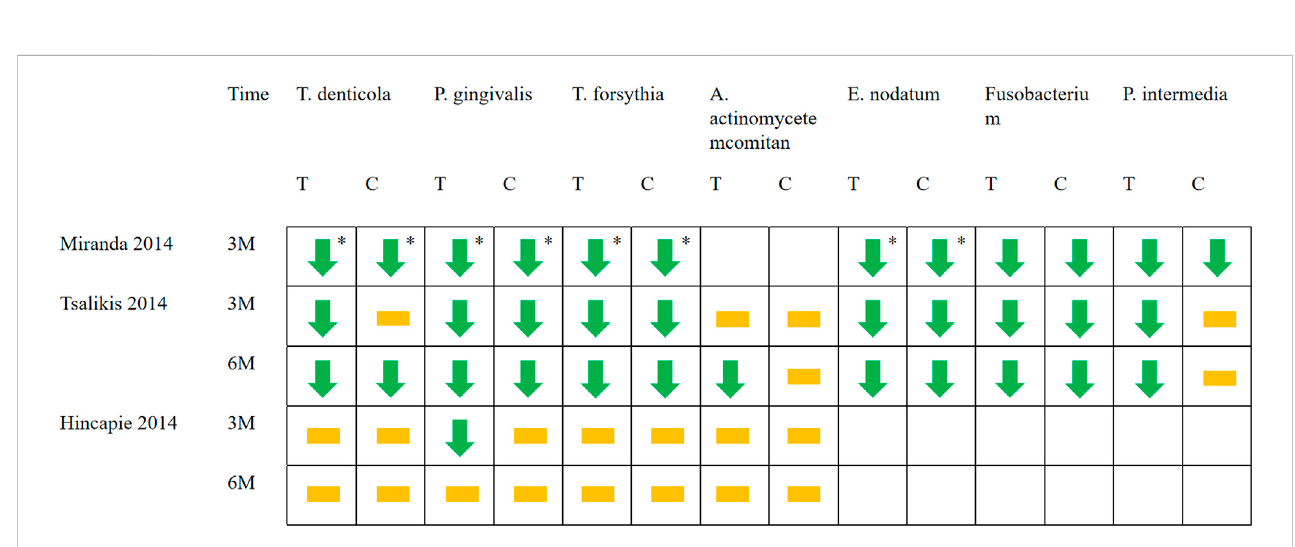
FIGURE 7 Changes in bacterial species applied with systemic antibiotics. Green arrows represent the decrease of a certain bacteria in this period compared with baseline( p < 0.05).Theyellowsquaresrepresentthatcomparedwiththebaseline,althoughtherearenumericalchangesinthenumberofbacteria,thereisno statistical difference. * Represents between-group differences ( p < 0.05). T represents test group and C represents control group.